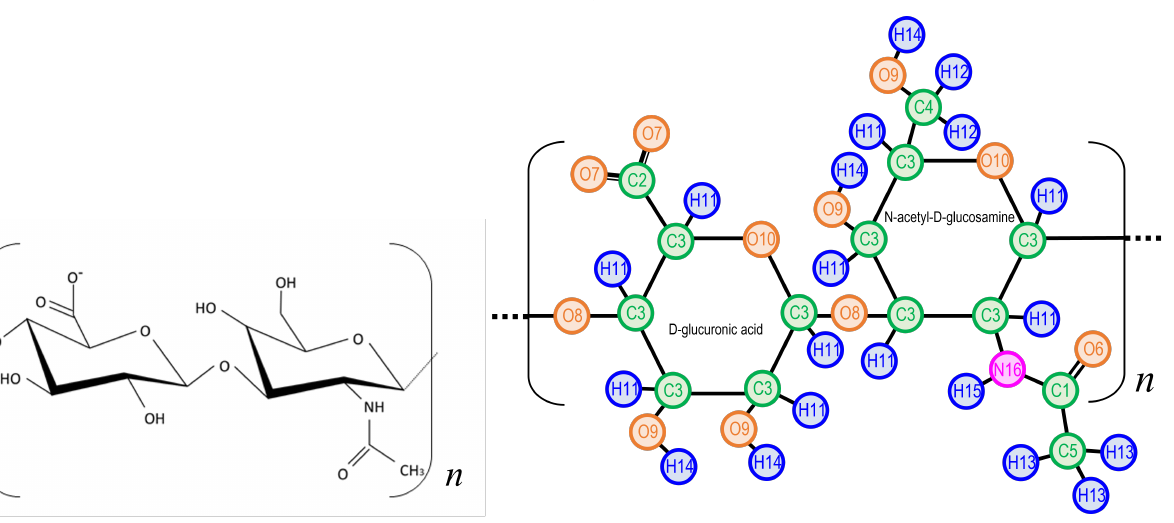
Figure 1. HA model. ( Left ) structural formula, ( Right ) atom type indices assigned with ParamChem [29]. Four unit ( n = 4) molecules are used in the